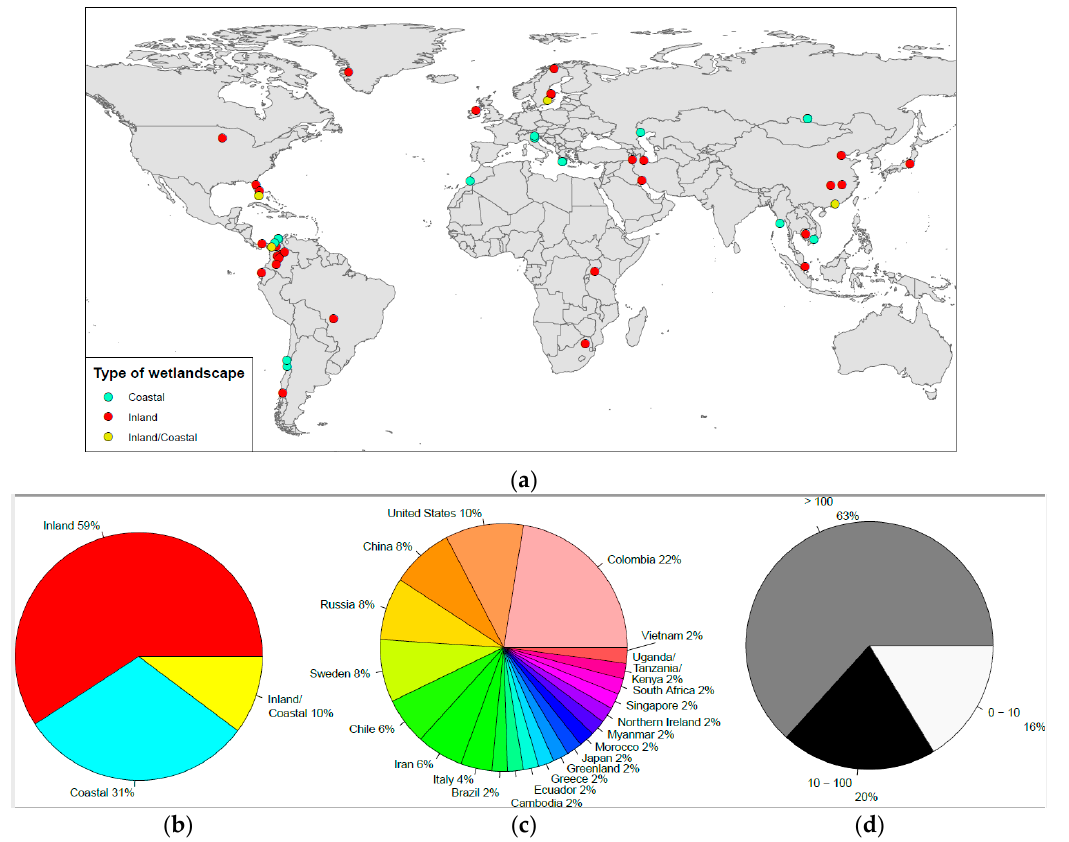
Figure 1. ( a ) Location of the 45 wetlandscapes in the Sustainable Development Goals (SDG) assessment, ( b ) Proportion of inland and coastal wetlandscapes, or both, ( c ) Countries where the wetlandscapes of the study are located with proportion of the total number of wetlandscapes, ( d ) Proportion of sizes of the wetlandscapes, classified in the ranges 0 to 10 km 2 , 10 to 100 km 2 and more than 100 km 2 .